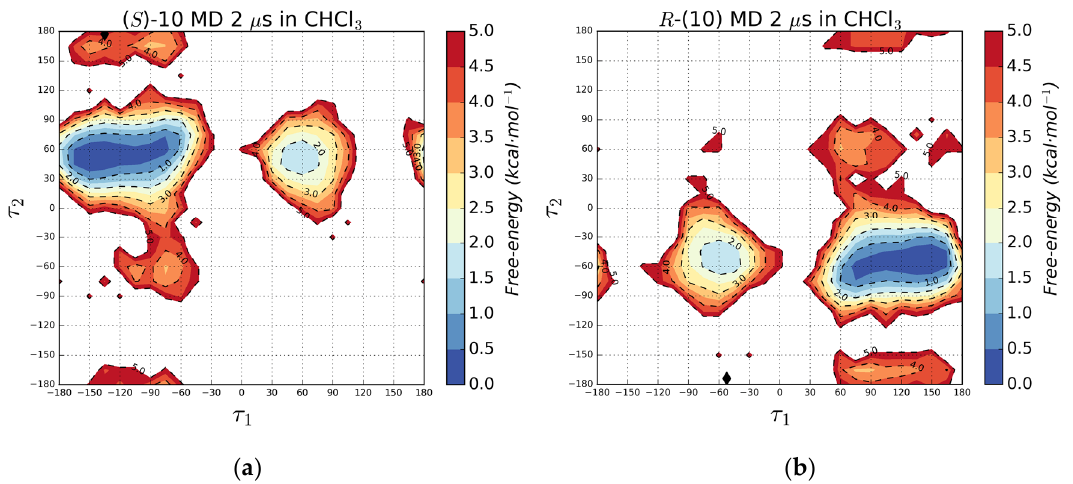
Figure 6. Free energy surfaces for ( S )- 10 ( a ) and ( R )- 10 ( b ) after 2 µs of molecular dynamics simulation in chloroform. Dihedral values assumed in the minimized docking poses are shown as black diamonds.